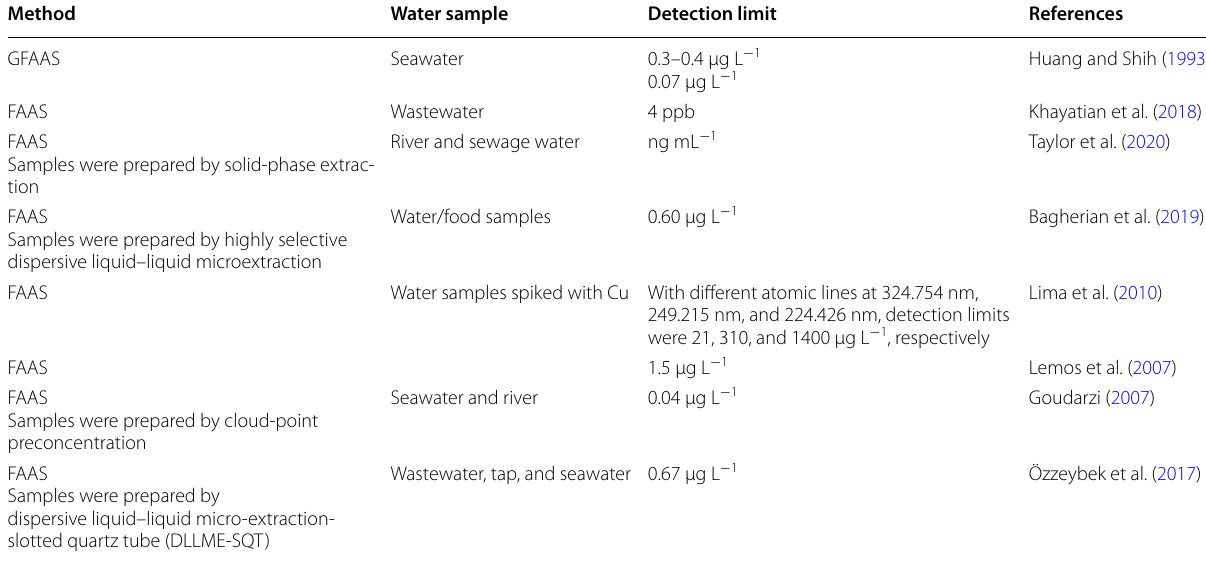
Table 1 Summary of conducted studies on Cu detection by AAS in water samples